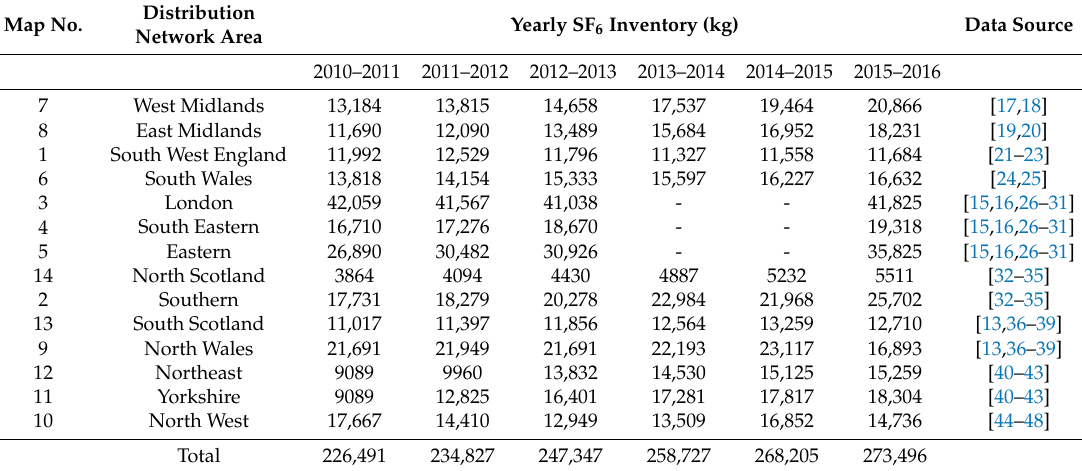
Table 3. SF 6 Inventory held in each electricity distribution network area (kg) in Great Britain. Map